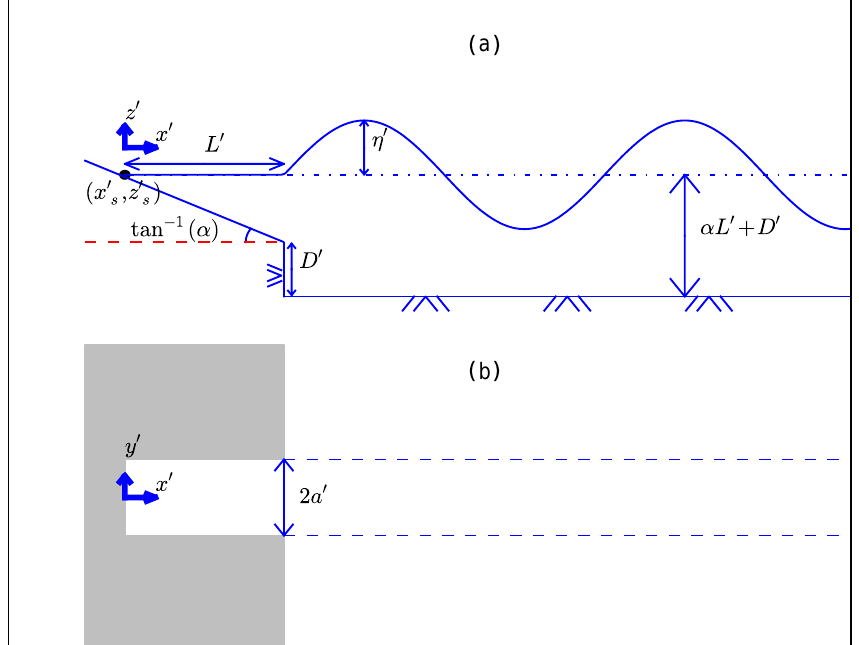
Figure 1. Panel (a) is the side view of the incident wave at instant t (cid:48) = 0 . The black dot is the shoreline, and ( x (cid:48) s , z (cid:48) s ) are its coordinates, with z (cid:48) s being equal to run-up r (cid:48) . Panel (b) is the geometry of the channel seen from above. In Model-1 the sloping channel is connected to a deeper channel of the same width, see broken lines in panel (b) . In Model-2 the channel opens to a semi-infinite ocean. The width of the channel is 2 a (cid:48) . Non-dimensional quantities are defined as x = x (cid:48) /L (cid:48) , y = y (cid:48) /L (cid:48) , z = z (cid:48) /(αL (cid:48) ) , η = η (cid:48) /(αL (cid:48) ) , D = D (cid:48) /(αL) and a = a (cid:48) /L (cid:48) .